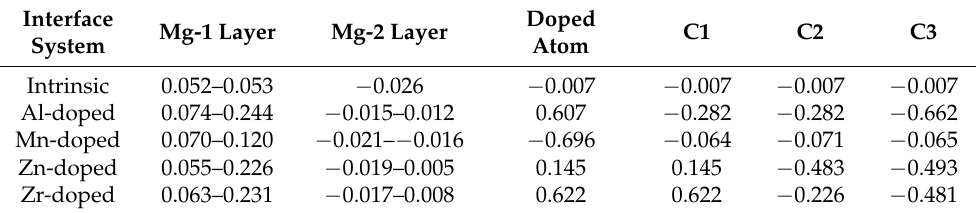
Table 7. Mulliken atomic charges (MAC) of the atoms in five interface models.